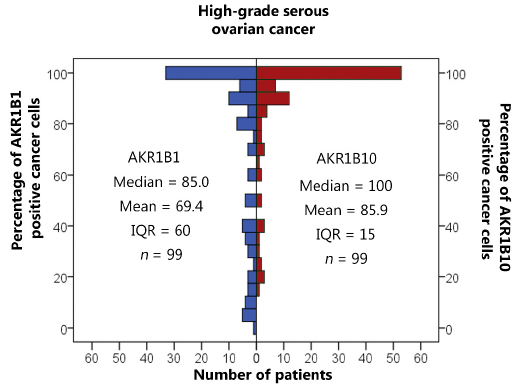
Figure 1. Immunohistochemical staining of AKR1B1 and AKR1B10 in high-grade serous ovarian cancer. The graph shows the numbers of cases with the associated percentages of positive cancer cells. AKR1B1: aldo-keto reductase family 1 member B1; AKR1B10: aldo-keto reductase family 1 member B10; IQR: interquartile range; n : number of patients.